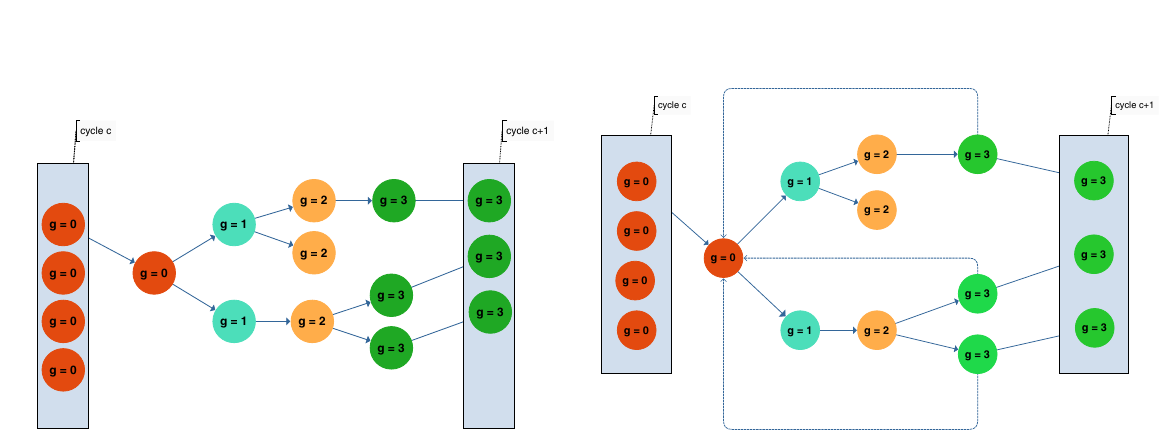
Figure 1: Left. Cycle-wise tree structure of a neutron and its progeny in the super-history method for L = 3 . Right. Adjoint-weighting scheme of a neutron history by the super-history method: the number of latent generations M is equal to the number (minus one) of generations L in the underlying super-history